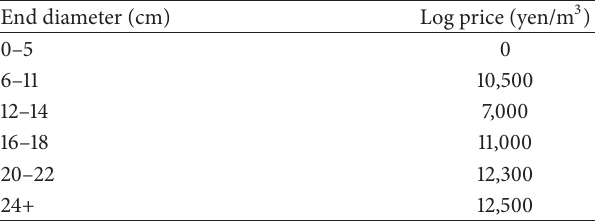
Table 1: Relationship between end diameter and log